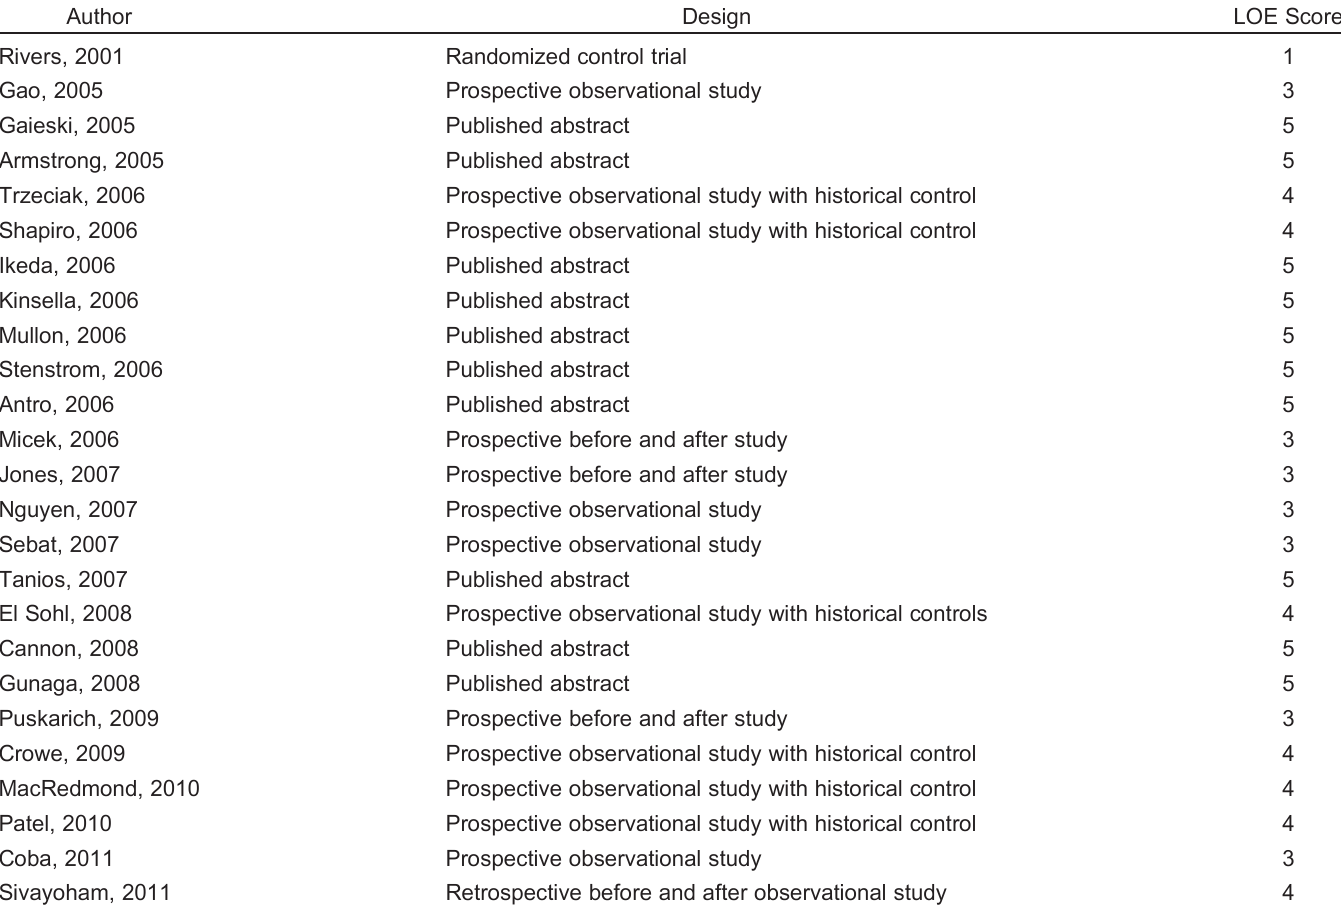
Table 3. Methodologic scores of identified trials that analyzed adult controlled trials implementing protocolized hemodynamic optimization in the emergency department for patients with severe sepsis and septic